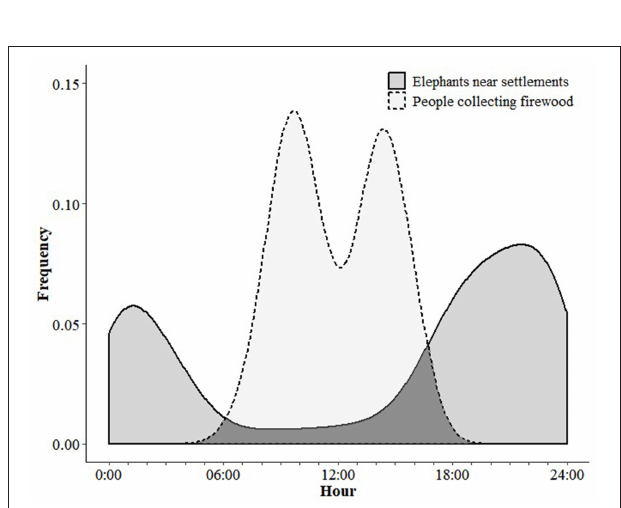
FIGURE 3 | Contrasting temporal pattern of firewood collection by people and frequency of elephant proximity near settlements (within 250 meters).